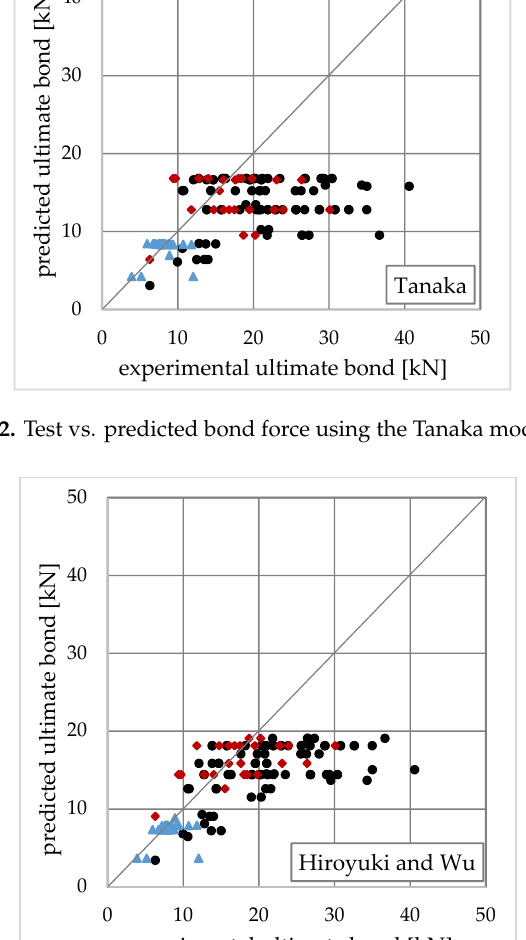
Figure 5. Test vs. predicted bond force using the Taljsten model [17].